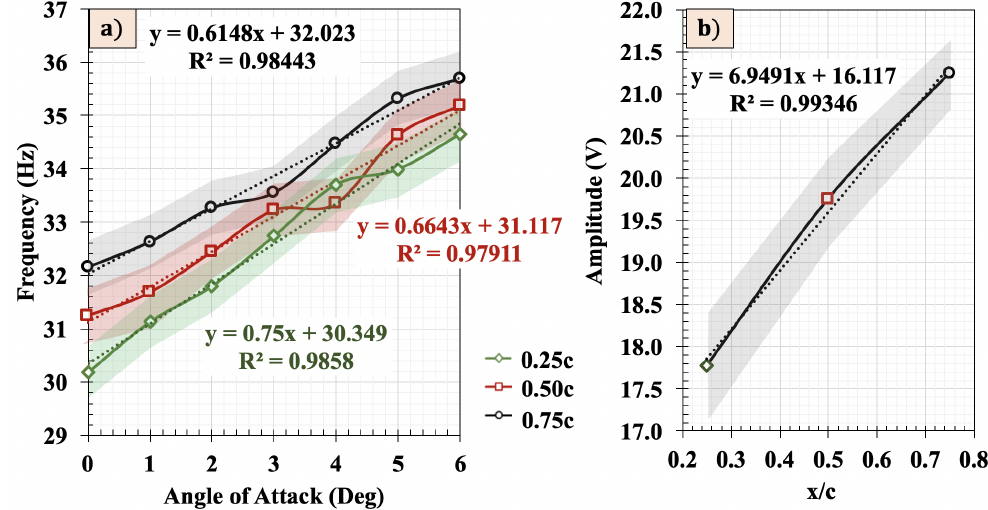
Figure 15. ( a ) variation of PVDF oscillation frequency with angle of attack; ( b ) variation of amplitude of PVDF oscillation as a function of downstream